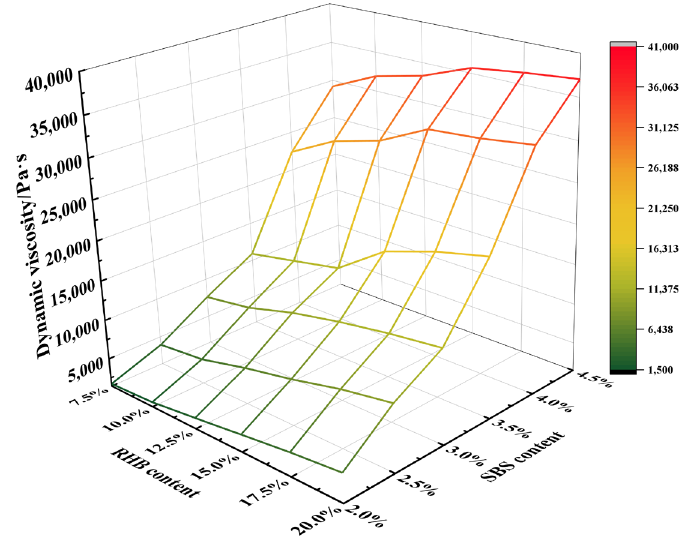
Figure 6. Dynamic viscosity of composite-modified asphalt.